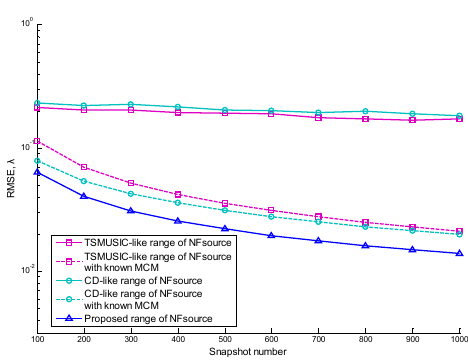
Figure 6. RMSEs of the range estimates versus snapshot number.